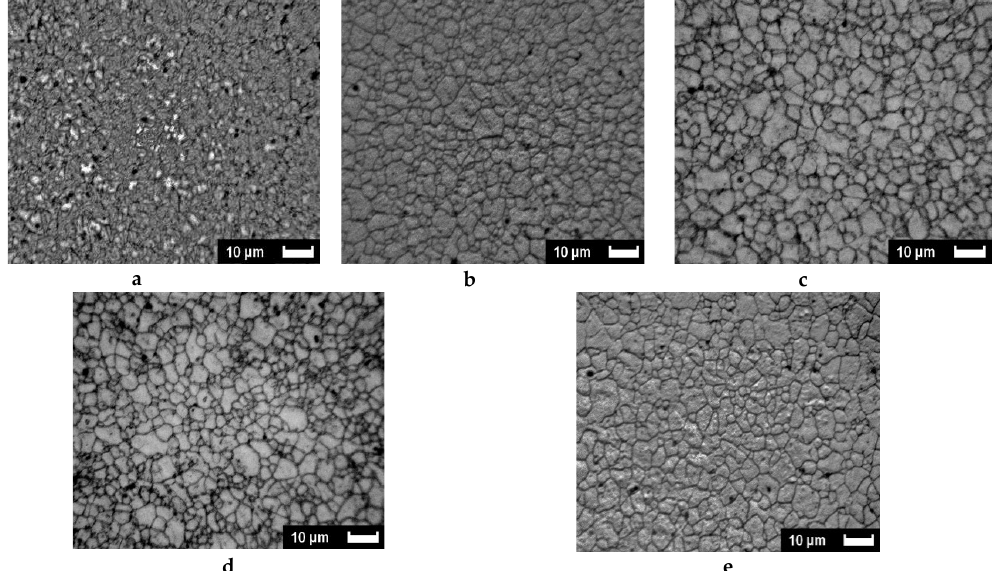
Figure 13. Microstructure versus the number of B C ECAP passes of AZ31 billets after ECAP B C passes at 250 °C: a —2 passes, b —4 passes, c —5 passes, d —8 passes, e —9 passes.